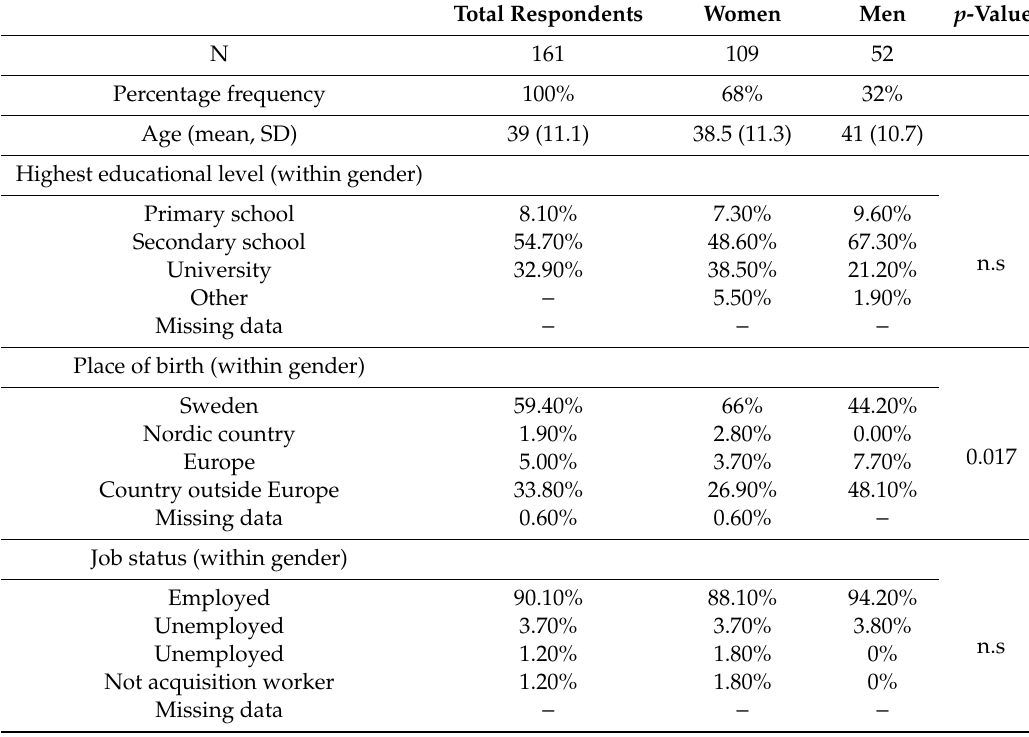
Table 1. Patient demographics and pain characteristics. Values for women and men are reported separately. Total Respondents Women Men p -Value N 161 Percentage frequency